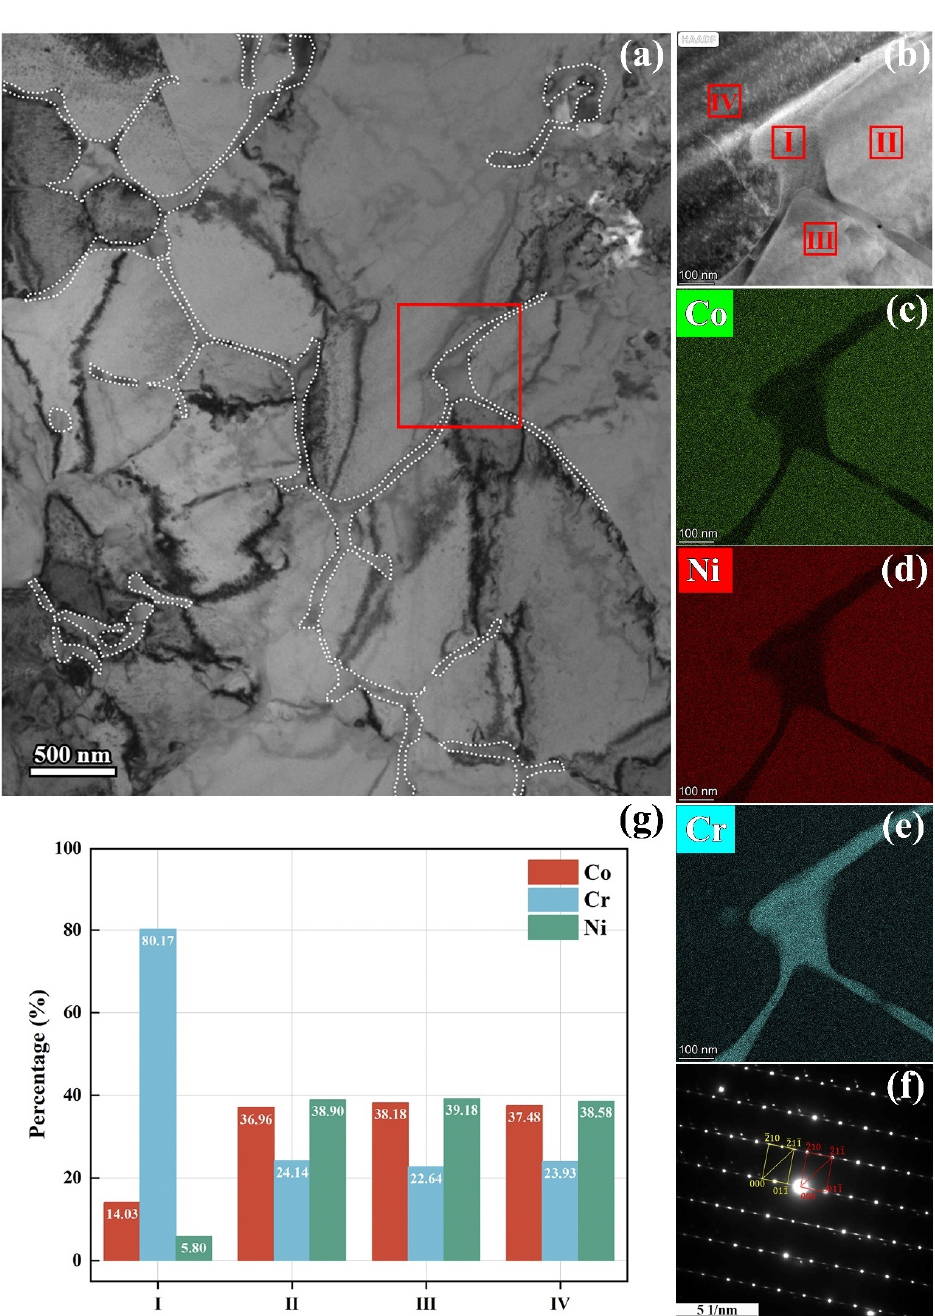
Figure 6. Microstructural analysis of CoCrNi residual jet after penetration by TEM: ( a ) TEM images of CoCrNi residual jet; ( b ) HAADF-TEM image of the precipitation (red rectangle region in ( a )); ( c – e ) Corresponding element distributions of Co, Cr, and Ni in ( b ); ( f ) SAED pattern of precipitation (region I in ( b )); ( g ) Element content of Co, Cr, and Ni in region I, II, III, IV in ( b ). The white dashed line in ( a ) marks the nanosized precipitations along grain